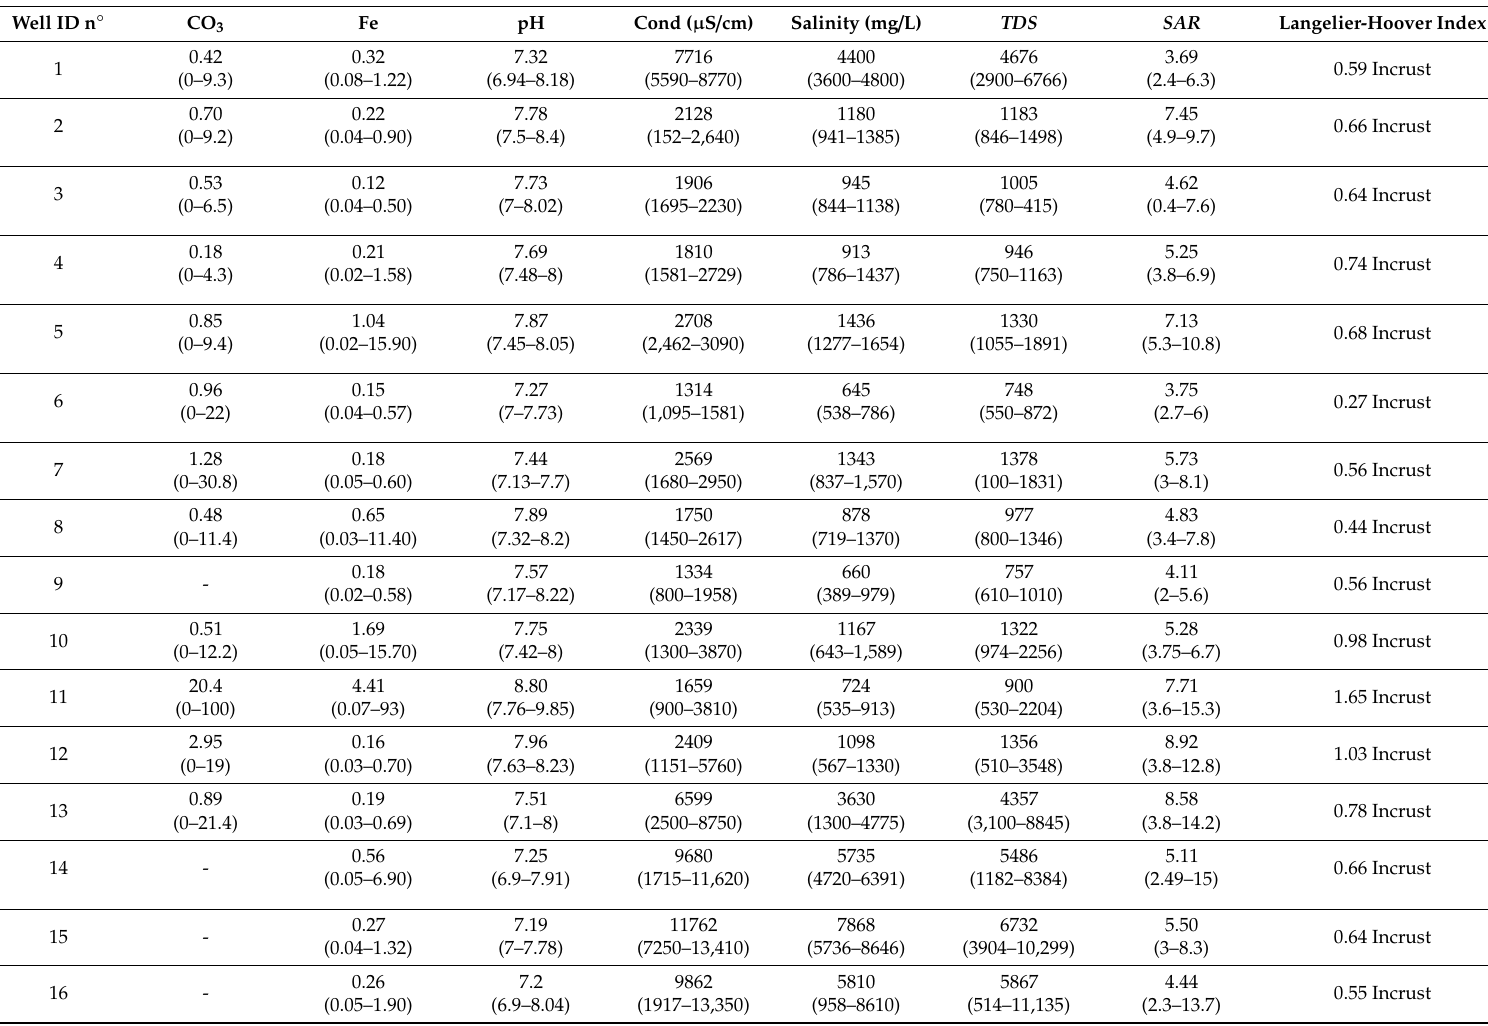
Table 5. Average of carbonate, iron and physical parameters and quality grades (minimum and maximum values between